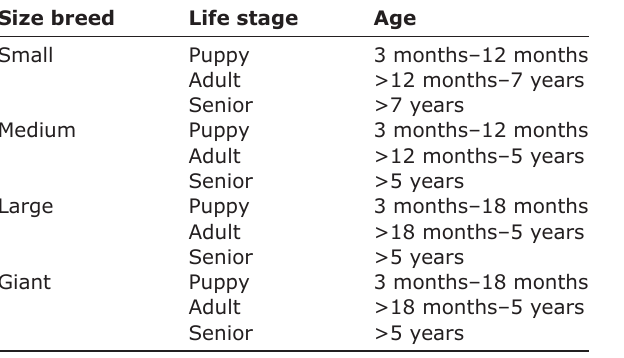
Table-1: Life stage classification of bitches [11]. Size